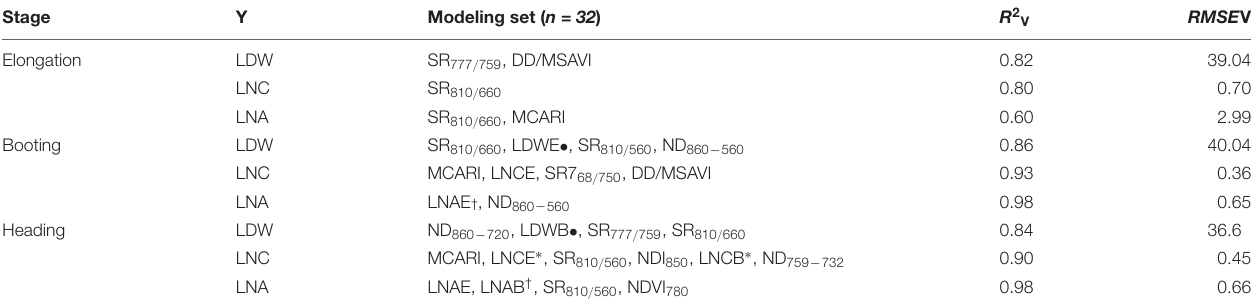
TABLE 5 | Validation of SMLR models for estimation of leaf nitrogen status indicators (LDW, LNC, and LNA) over growth stages of rice. Stage Y Modeling set ( n = 32 ) R 2 V RMSE V Elongation LDW SR 777 / 759 , DD/MSAVI